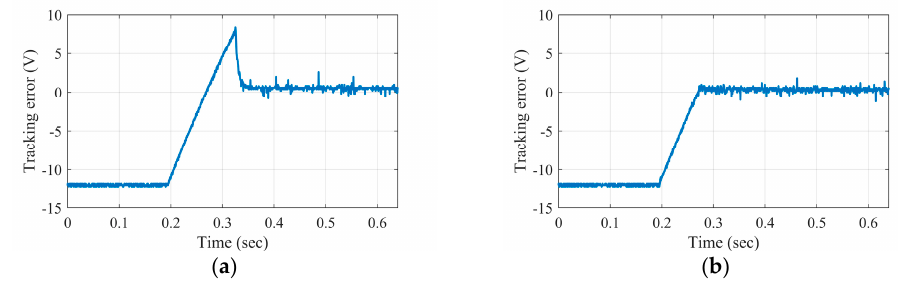
Figure 4. Tracking performance in Case 1 with resistance load, ( a ) PI control, and ( b ) FTSM-ELM control.